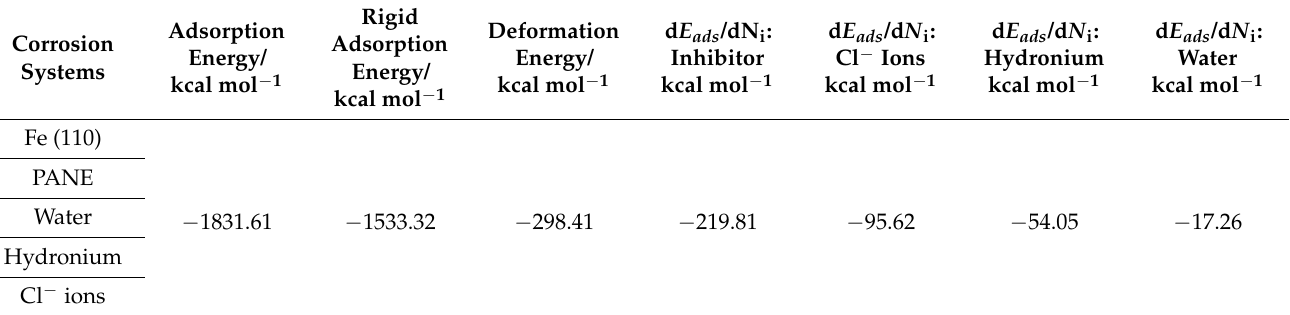
Table 4. Information and parameters derived from MC simulations of the PANE, ZnO@PANE,